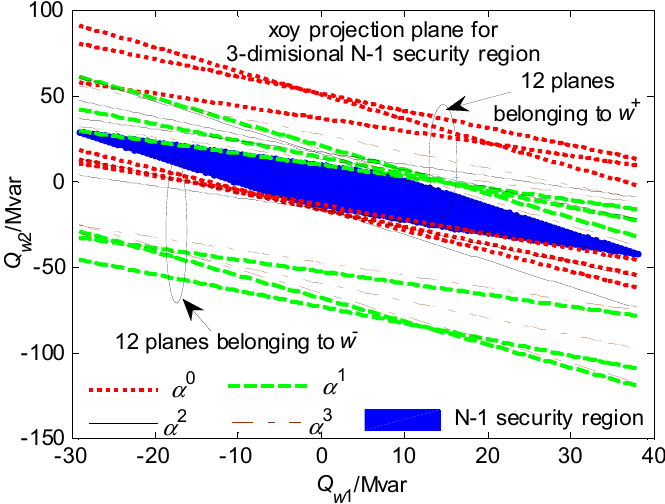
Figure 8. Projection of the N-1 voltage security region on the ( Q α 2 , and α 3 represents the planes belonging to A 0 , A 1 , A 2 , and A 3 .